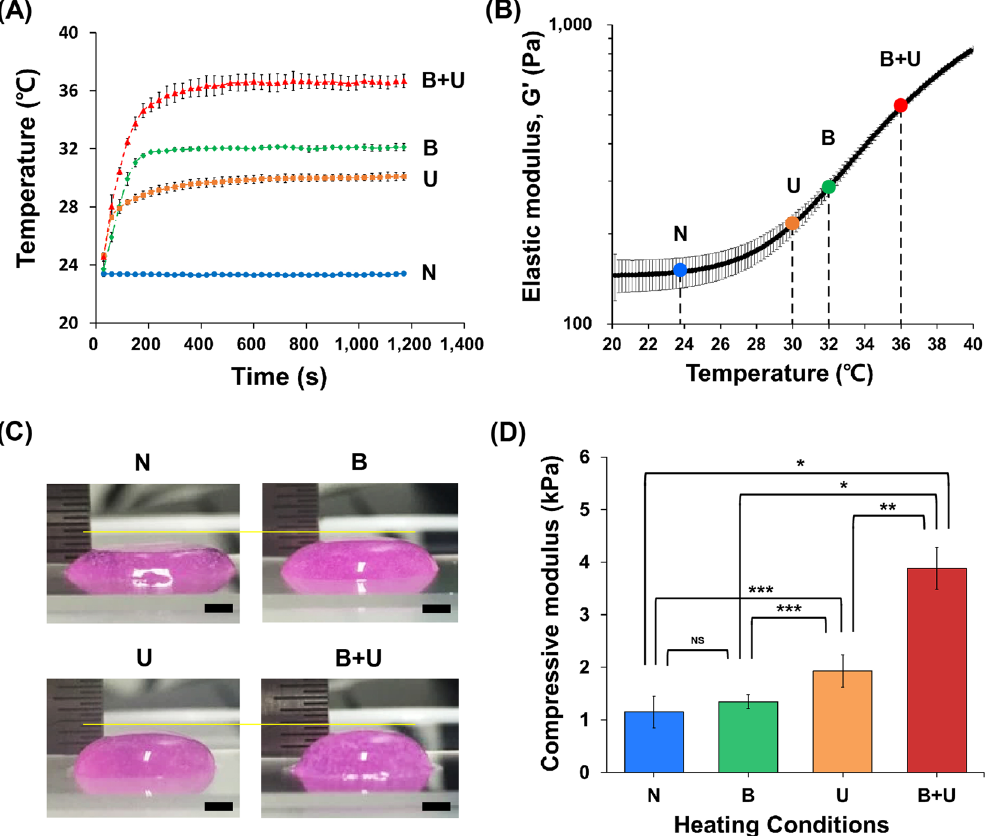
Figure 6. Efficacy of heating systems. ( A ) Results of saturation temperature measurement for each condition. ( B ) Temperature sweep oscillatory tests with a temperature ramp of 5°C/min from 20 °C to 40 °C. ( C ) 3D stacking results of bioinks with different heating condition. ( D ) Compressive moduli of the printed structures under each heating condition. ( * p < 0.001, ** p < 0.005, *** p <